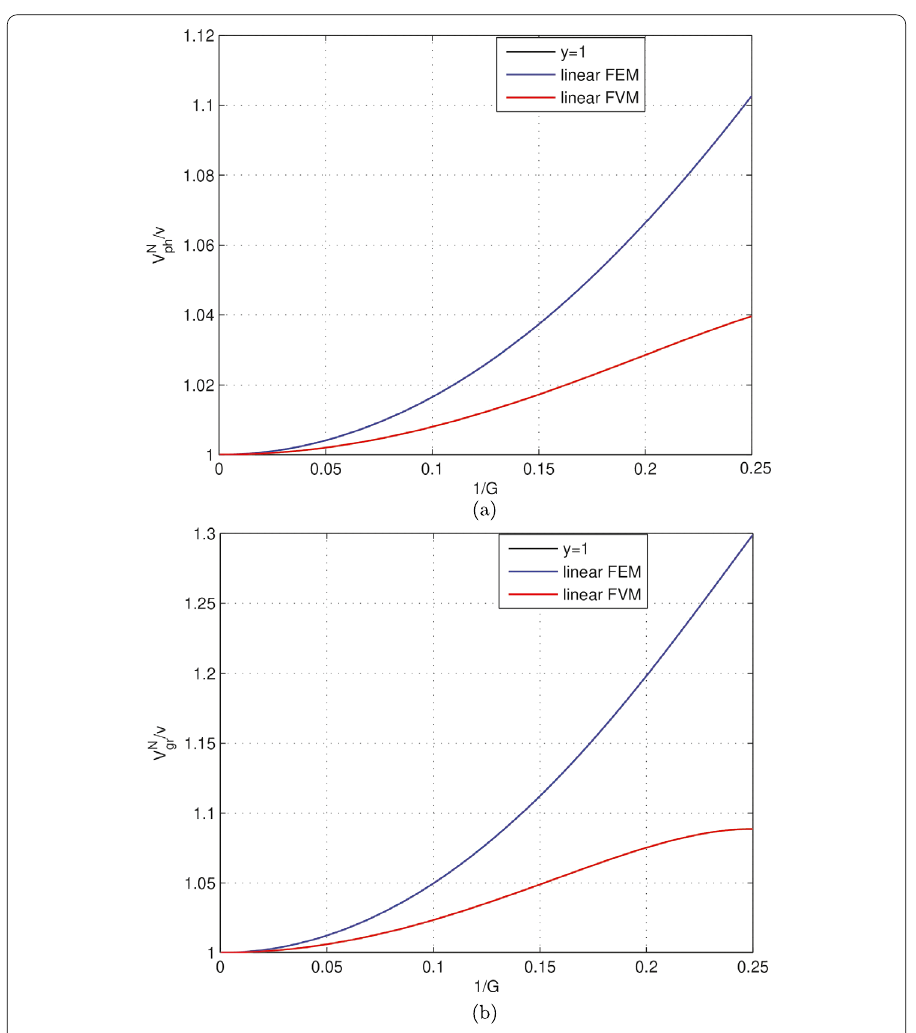
Figure 1 ( a ) Normalized phase velocity curves for the linear FEM and FVM, ( b ) normalized group velocity curves for the linear FEM and